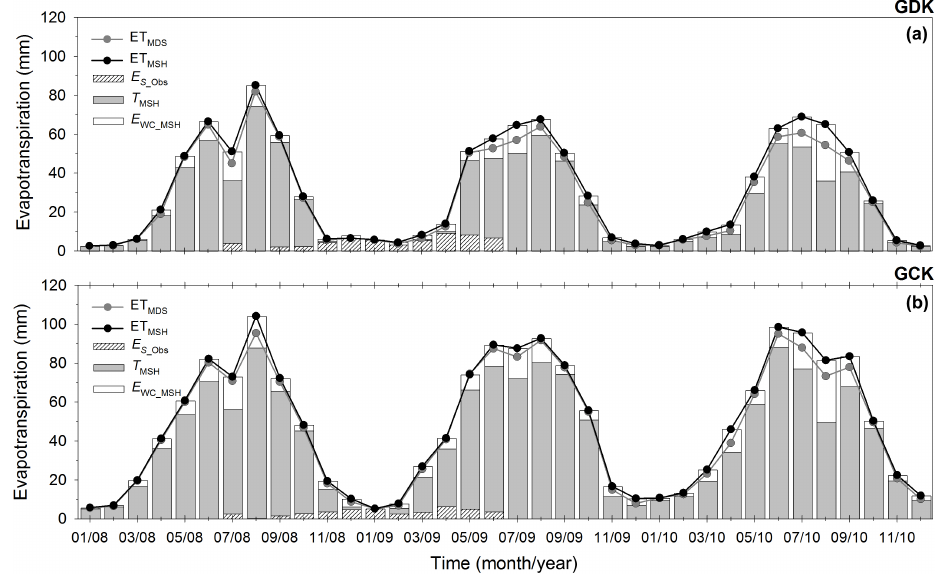
Figure 3. Seasonal variation of monthly integrated evapotranspiration (ET) with the gap-filled by the MDS method (ET MDS ) ; the ET gap- filled by the MSH method (ET MSH ) , transpiration and wet canopy evaporation partitioned by the MSH method ( T MSH and E WC_MSH ) , for the GDK (a) and GCK (b) sites. E S_Obs indicates soil evaporation measured by the supplementary eddy covariance systems at the floors (adapted from Kang et al., 2009b).